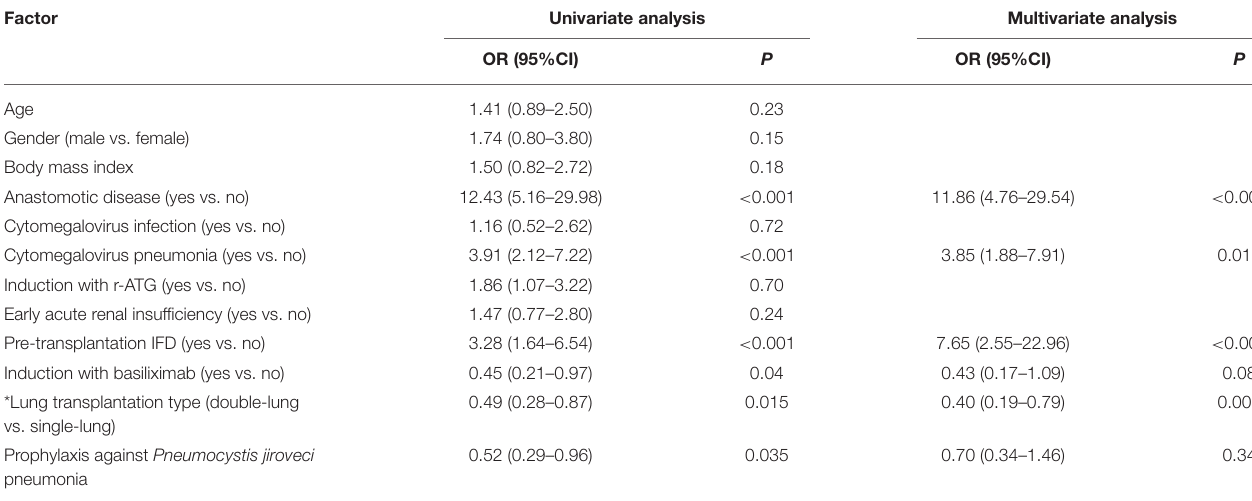
TABLE 2 | Logistic regression analyses of factors associated with invasive fungal disease in lung transplant recipients. Factor Univariate analysis Multivariate